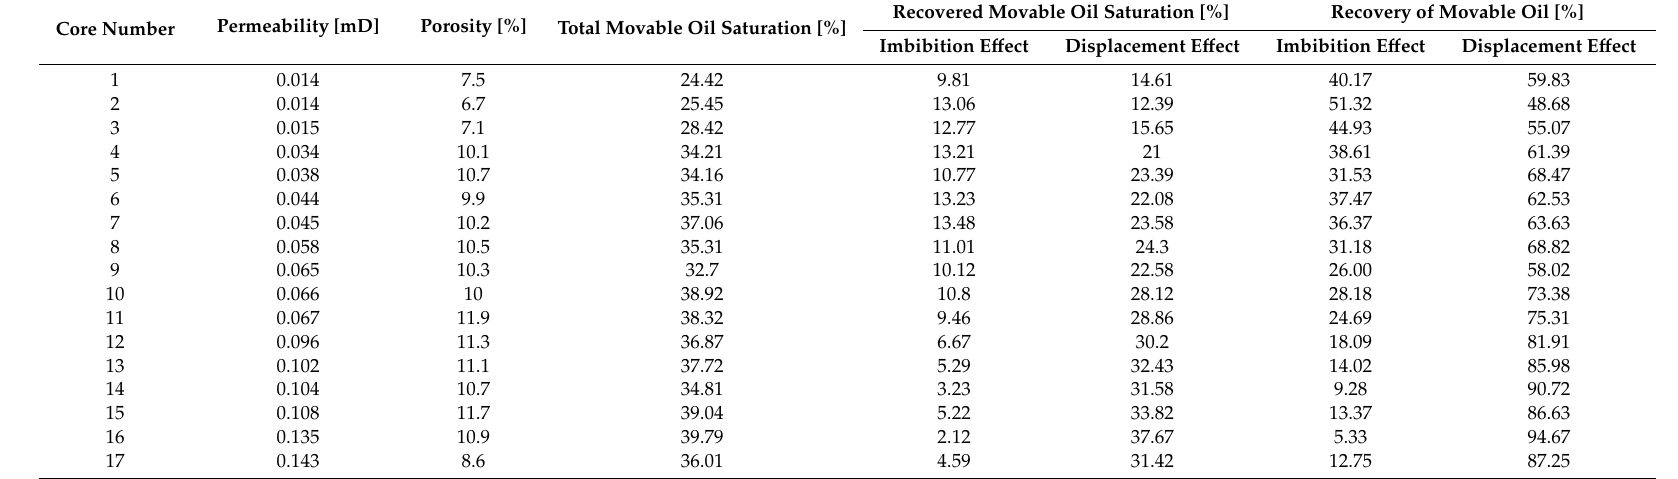
Table 3. Movable oil recoveries a ff ected by imbibition and displacement in Chang 7 tight